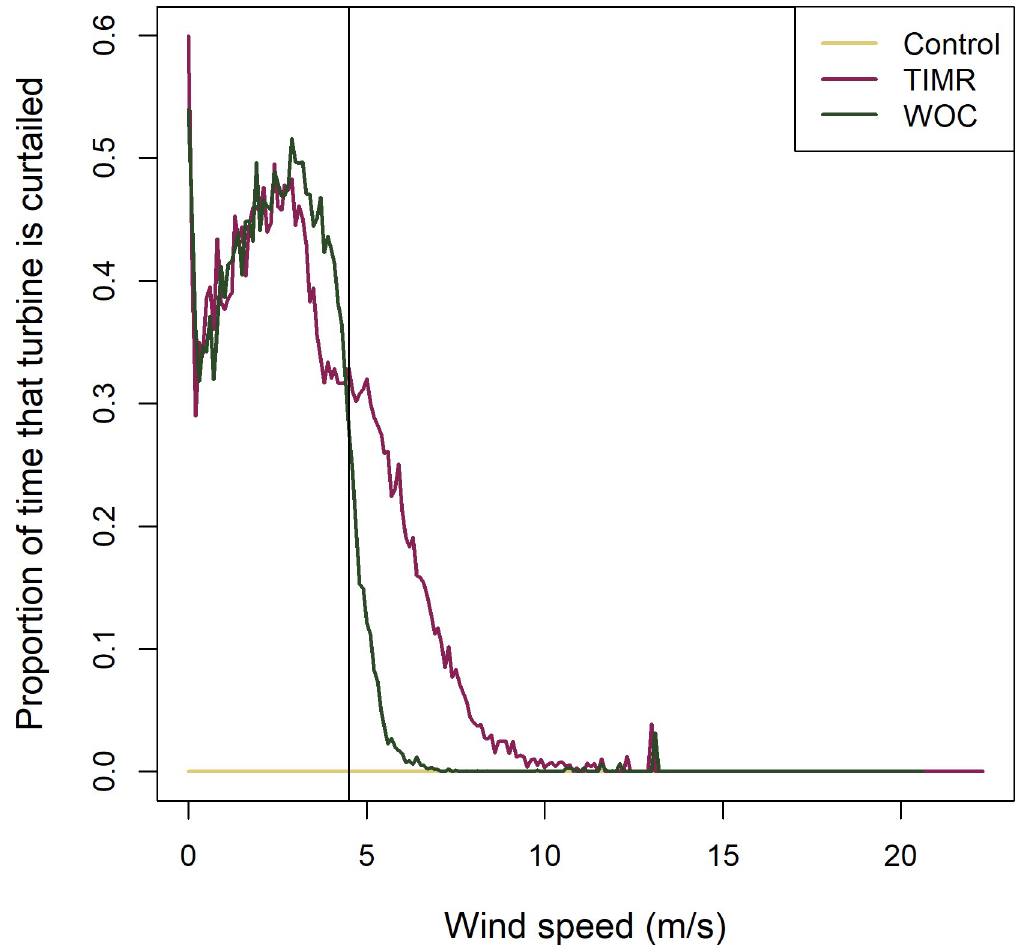
Fig 3. Proportion of time that study turbines were curtailed, by wind speed, at the Blue Sky Green Field Wind Energy Facility, Fond du Lac County, Wisconsin, from July 15 − September 30, 2015. Data were collected at 10 control turbines (Control), 10 wind speed-only curtailed (WOC) turbines with a cut-in speed of 4.5 m/s, and 10 Turbine Integrated Mortality Reduction (TIMR) system-curtailed turbines.